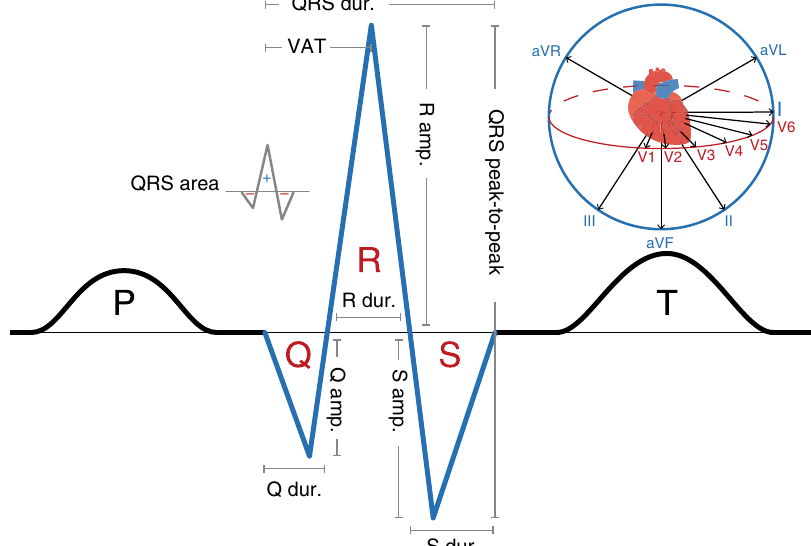
Fig. 1 ECG wave and the QRS complex. We denote QRS measures used in the analysis with grey lines. We illustrate the different viewpoints of the 12 ECG leads in the upper-right corner. Amp. amplitude, Dur. duration, VAT ventricular activation